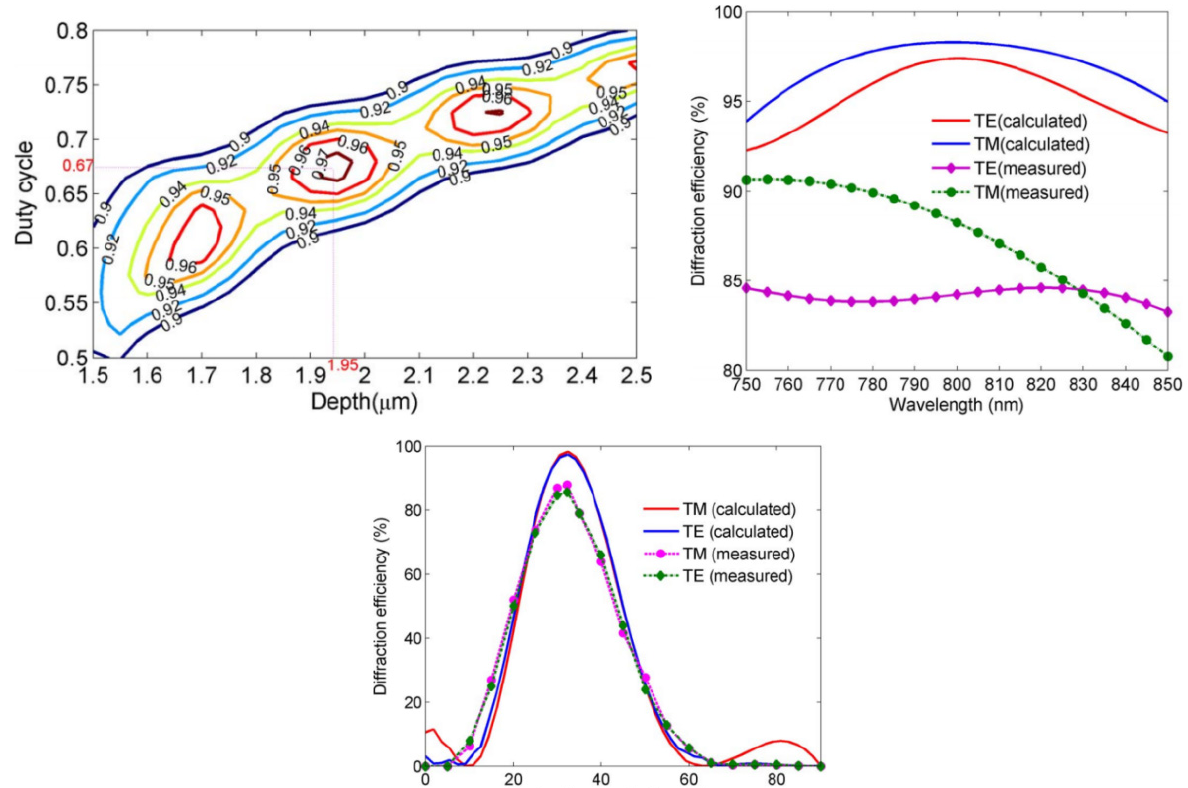
Figure 29. Theoretical and experimental (lines with markers) diffraction efficiencies of the manufac- tured grating at different incidence angles for TM and TE polarizations.